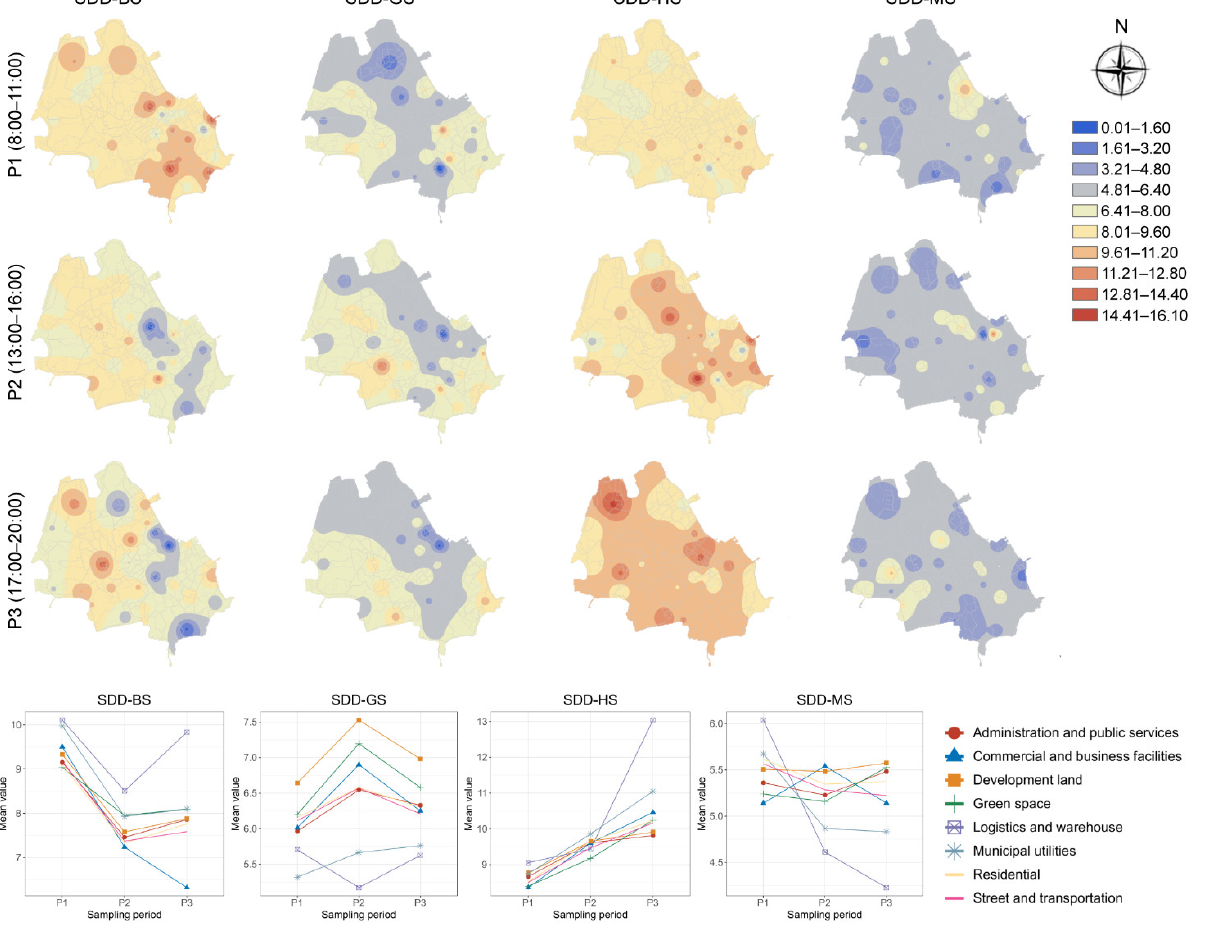
Figure 2. Spatiotemporal distribution and temporal variation of the mean values of sound source dominance of the four main category sound sources. Table 3. Rotated component matrices of the PCA based on semantic attributes (numbers in parenthe- ses represent explained